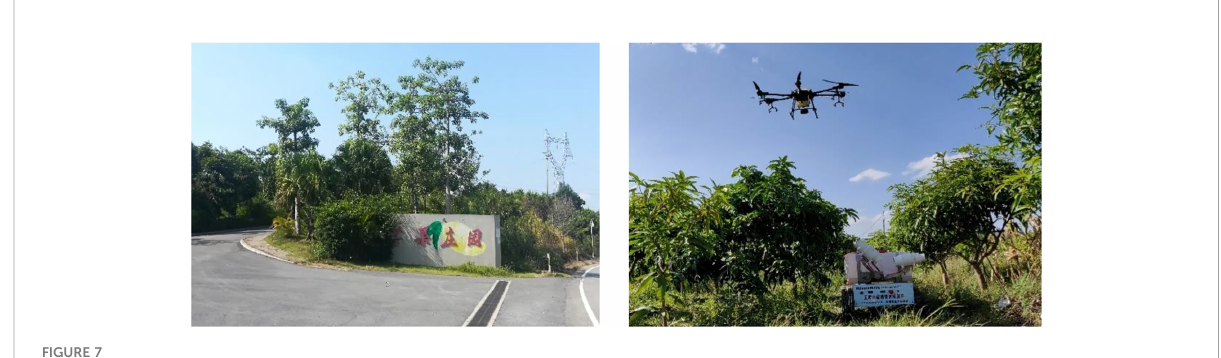
FIGURE 7 Experimental scenarios.